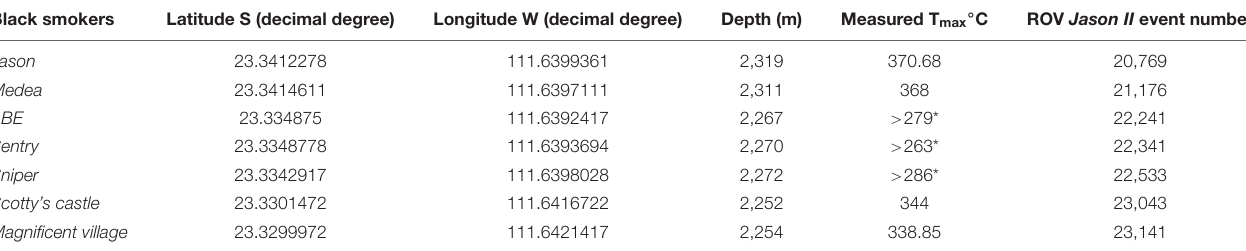
FIGURE 3 | Examples of hydrothermally inactive (relict) sulfide substrata at Pito Seamount: (A) chimney; (B) boulders; (C) ledge; (D) debris; (E) example of brisingids on relict chimneys close to Scotty’s Castle black smoker; (F) six-armed brisingid on olivine gabbro talus at 5,200 m in Pito Deep. TABLE 1 | Pito Seamount black smoker coordinates, depth, maximum temperature, and ROV Jason II event number. Black smokers Latitude S (decimal degree) Longitude W (decimal degree) Depth (m) Measured T max ◦ C ROV Jason II event